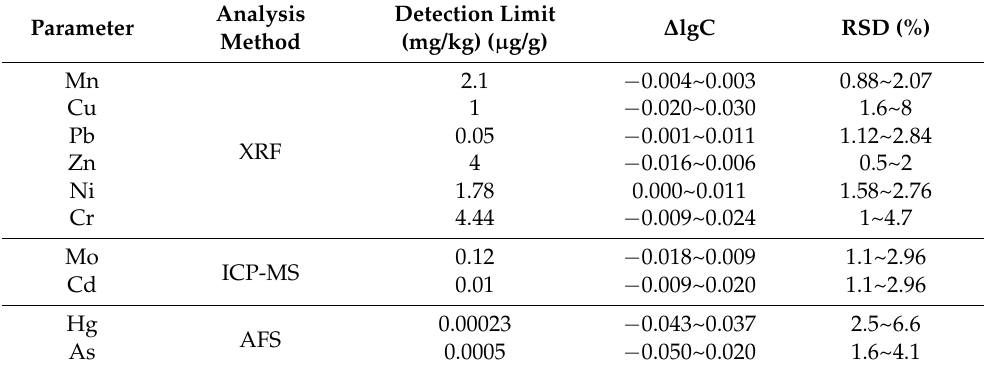
Table 1. Detection limits and precision of each parameter analysis